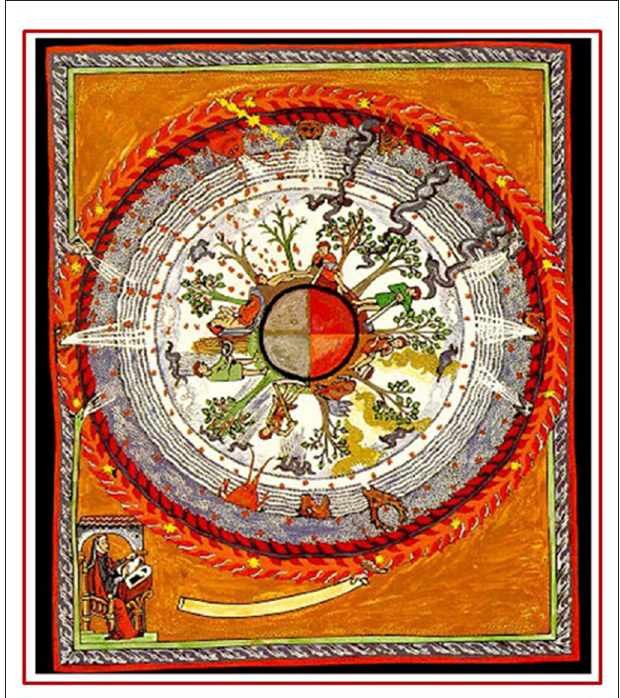
FIGURE 3 | Liber divinorum operum, f 38r., sec. XIII, Biblioteca Statale di Lucca, ms. 1942: In this vision, Hildegard gives importance to the Earth and to the influence that the higher elements exert on it. In particular, the four seasons and the man’s work are illustrated. The symbols of animal heads and the breath of winds underline the interdependence between all terrestrial and cosmic phenomena not only from a natural and physical point of view but also from an eschatological one’s. Lightning bolts and a smoky fog fall from the firmament on men capable of causing weakness and disease (represented by the suffering human figures) whenever man sins, disobeying the Living Light or whenever the soul and body are not in harmony. The image, therefore, summarizes the Hildegardian vision of the correspondence between human health and